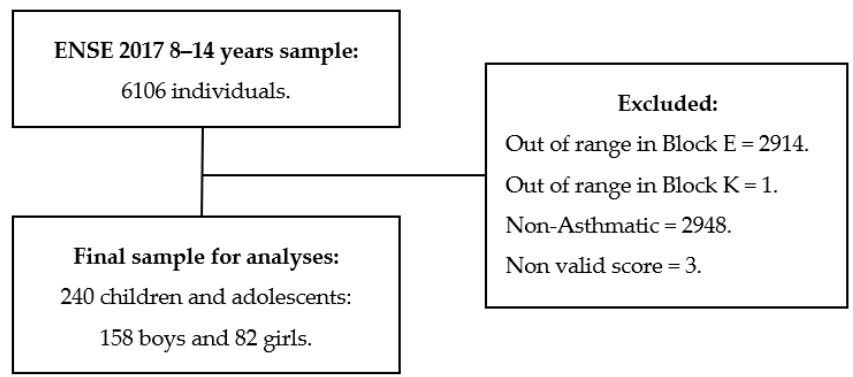
Figure 1. The study sample’s eligibility criteria